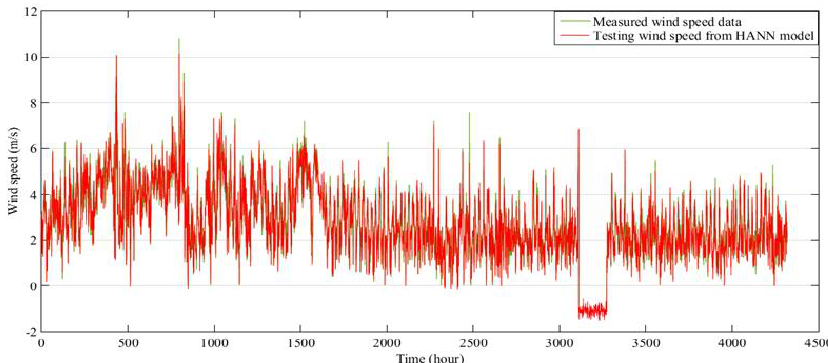
Figure 17. Comparison between measured and predicted hourly wind speed data for six months at Mersing, for validation of the HANN model.